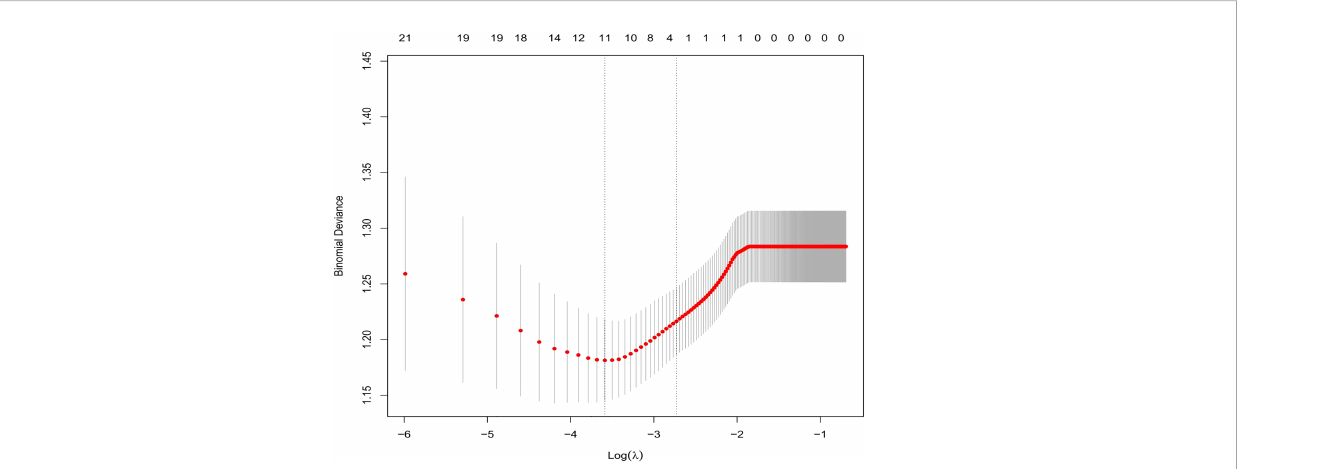
FIGURE 1 By using the fi ve-weight veri fi cation method, the optimal parameter (Lambda) (29) can be selected in the LASSO model. Using partially mild deviation curves (two deviations) and paired graphs (Lambda), a virtual line is drawn vertically at the optimal value to determine the characteristic factor.